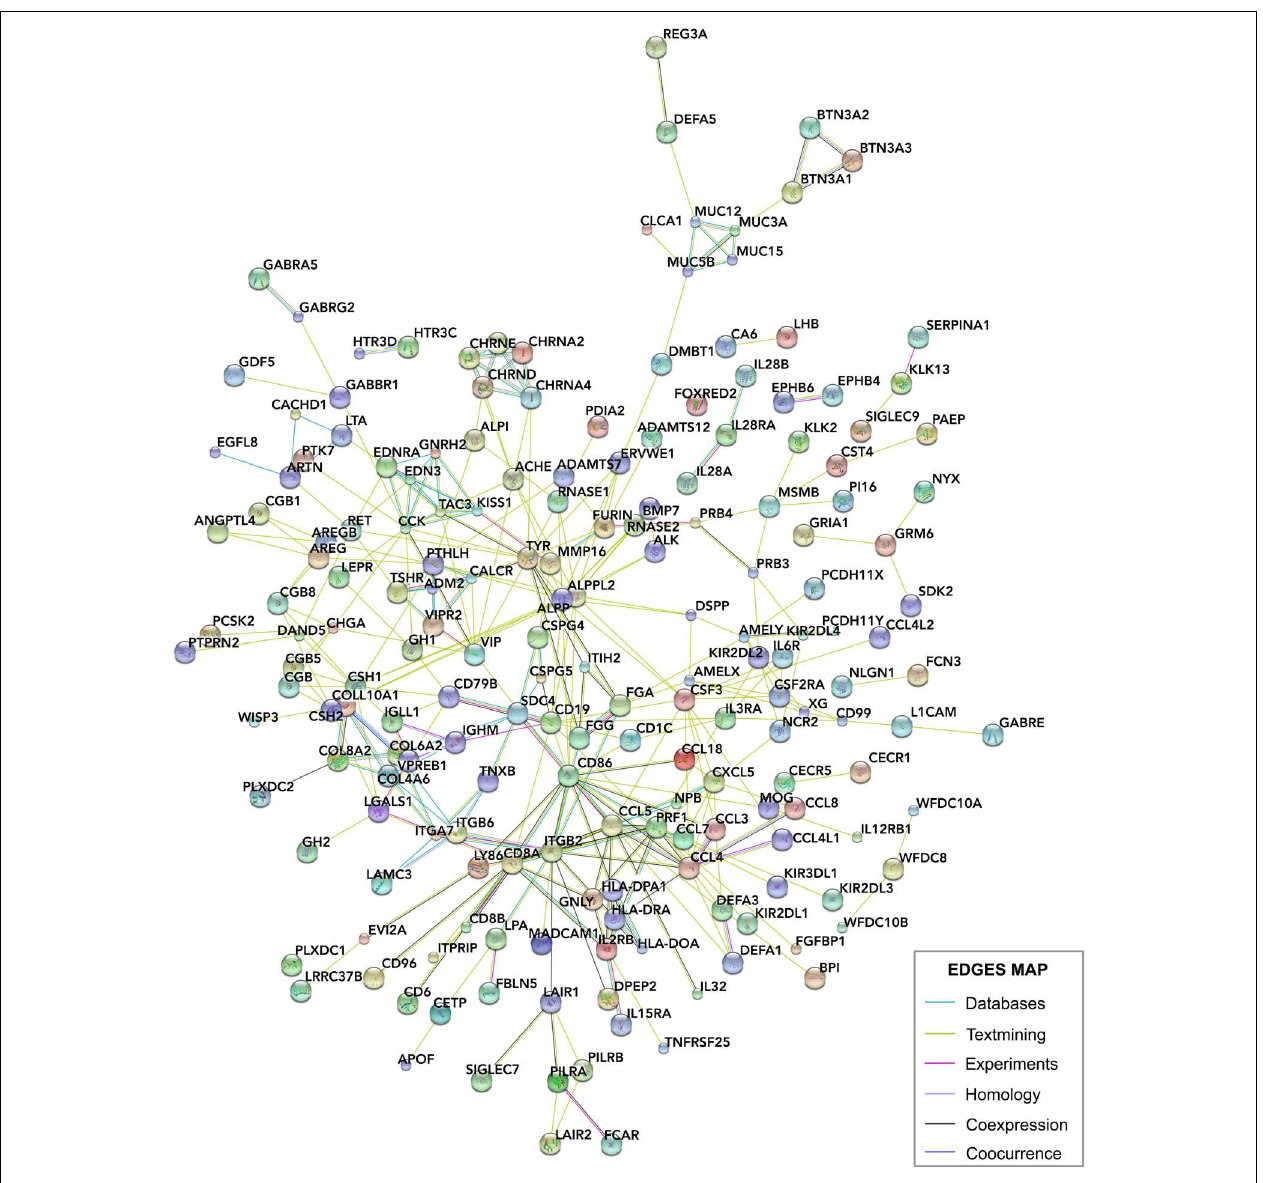
FIGURE 6 | STRING analysis of the interactions between placental genes. The signals and glycoprotein enriched module of human placental transcripts ( Figure 5B ) was analyzed using STRING 9.05 (http://string-db.org/), a database of known and predicted protein interactions, which responds by